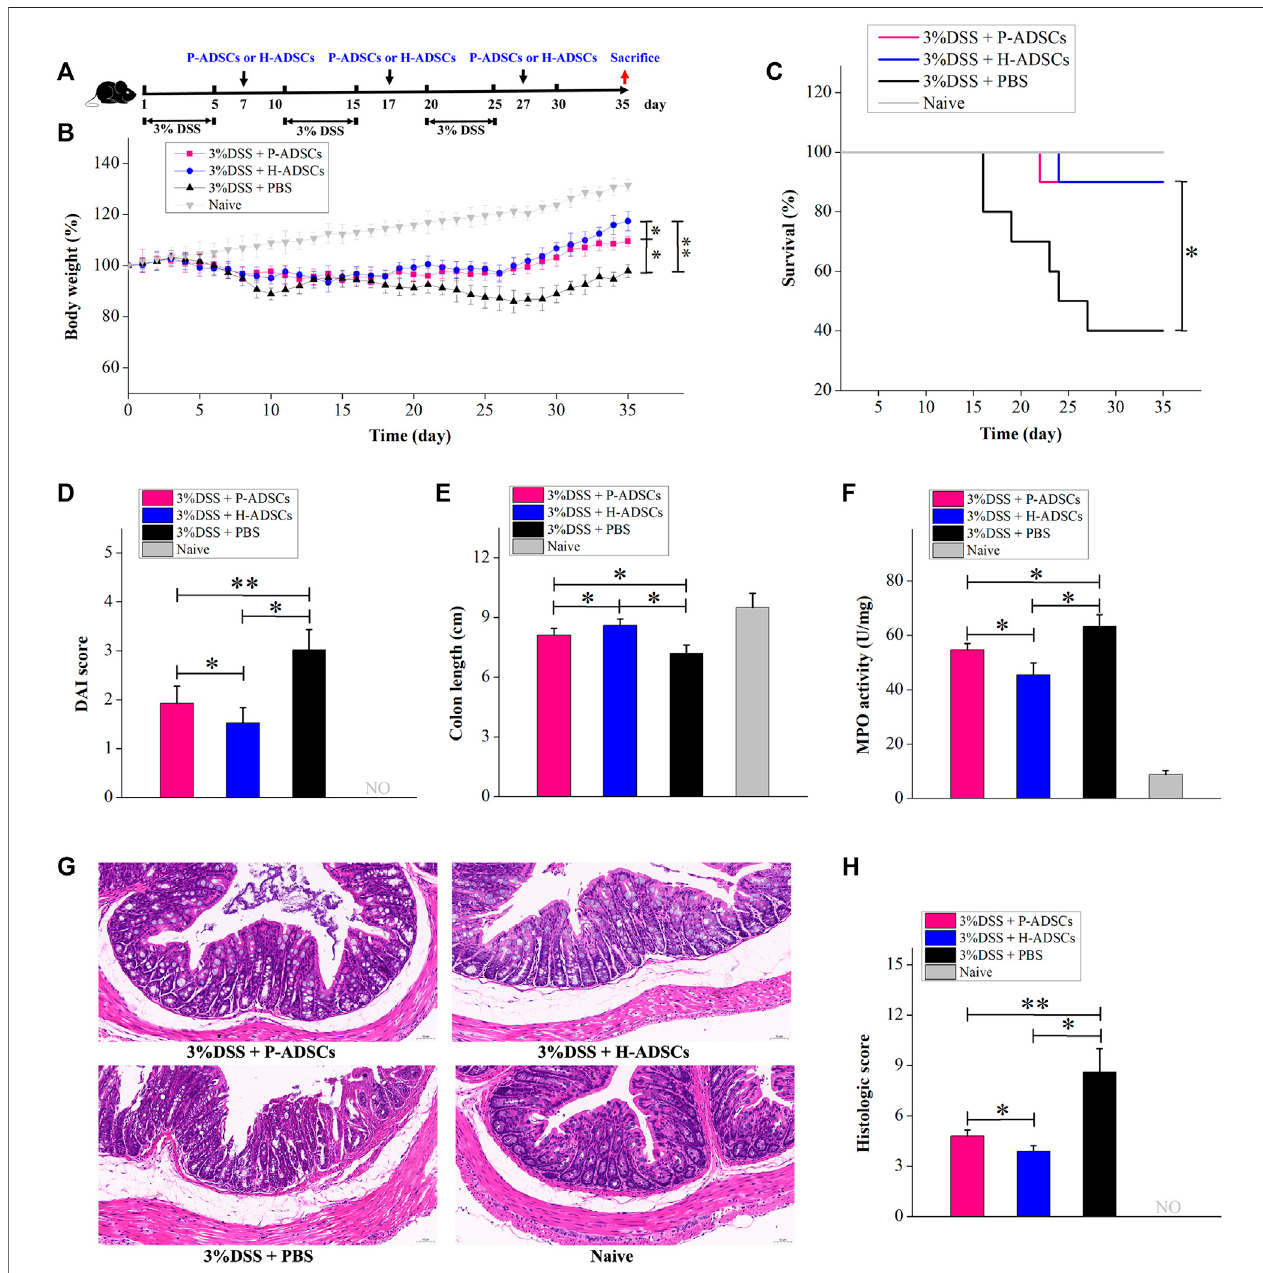
FIGURE7| P-ADSCsexhibitweakertherapeuticeffectsinamousechroniccolitismodelthanH-ADSCs (A) :Protocolforchroniccolitisinduction andH-ADSCsor P-ADSCsinjection (B) :Changesinweight,measureddailyand shownaspercentage changefromday 0.n ≥ 5micepergroup;* p < .05and** p < .01determinedbythe Kruskal – Wallis one-way analysis. (C) : Mortality was recorded. n ≥ 5 mice per group; * p < 0.05 determined by the Kruskal – Wallis one-way analysis. (D) : DAI scores were monitoredonday 35.n ≥ 5micepergroup; * p < .05and** p < .01determined bytheKruskal – Wallisone-wayanalysis. (E) :Colonlengthsonday35.n ≥ 5miceper group;* p < .05determinedbytheKruskal – Wallisone-wayanalysis. (F) :MPOactivityincolonsasameasureofneutrophilin fi ltrationonday35.n ≥ 5micepergroup;* p < .05 determined by the Kruskal – Wallis one-way analysis (G) : Representative images of colon tissue sections using histological examination. Original magni fi cation, ×200 (H) : Histological scores on day 35. n ≥ 5 mice per group; * p < .05 and ** p < .01 determined by the Kruskal – Wallis one-way analysis.